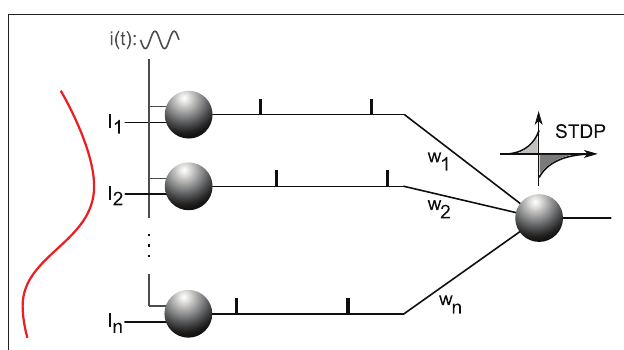
Figure 8 | Analog-to-phase conversion. Excitatory afferents 1 … n are shown on the left. They receive static input currents I common oscillatory drive i ( t ), which leads to a current-to-phase conversion: the stronger the current, the earlier the afferent fires during the oscillation cycle. All the afferents are connected through plastic synapses with weights w one downstream neuron equipped with STDP. This neuron will gradually become selective to the spike wave corresponding to the repeating current pattern (see Figure 9 ). Figure is modified from Deco et al. (2011).